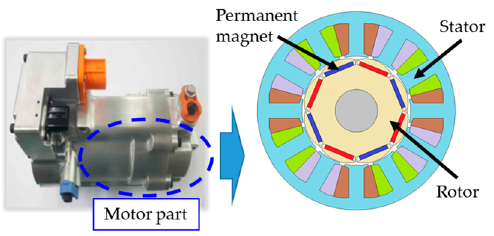
Figure 2. Shape of conventional permanent magnet synchronous motor (PMSM) for an electric compressor. Table 1. Specifications of the initial model of permanent magnet synchronous motor (PMSM) (rpm: revolutions per minute, EMF: electromotive force).